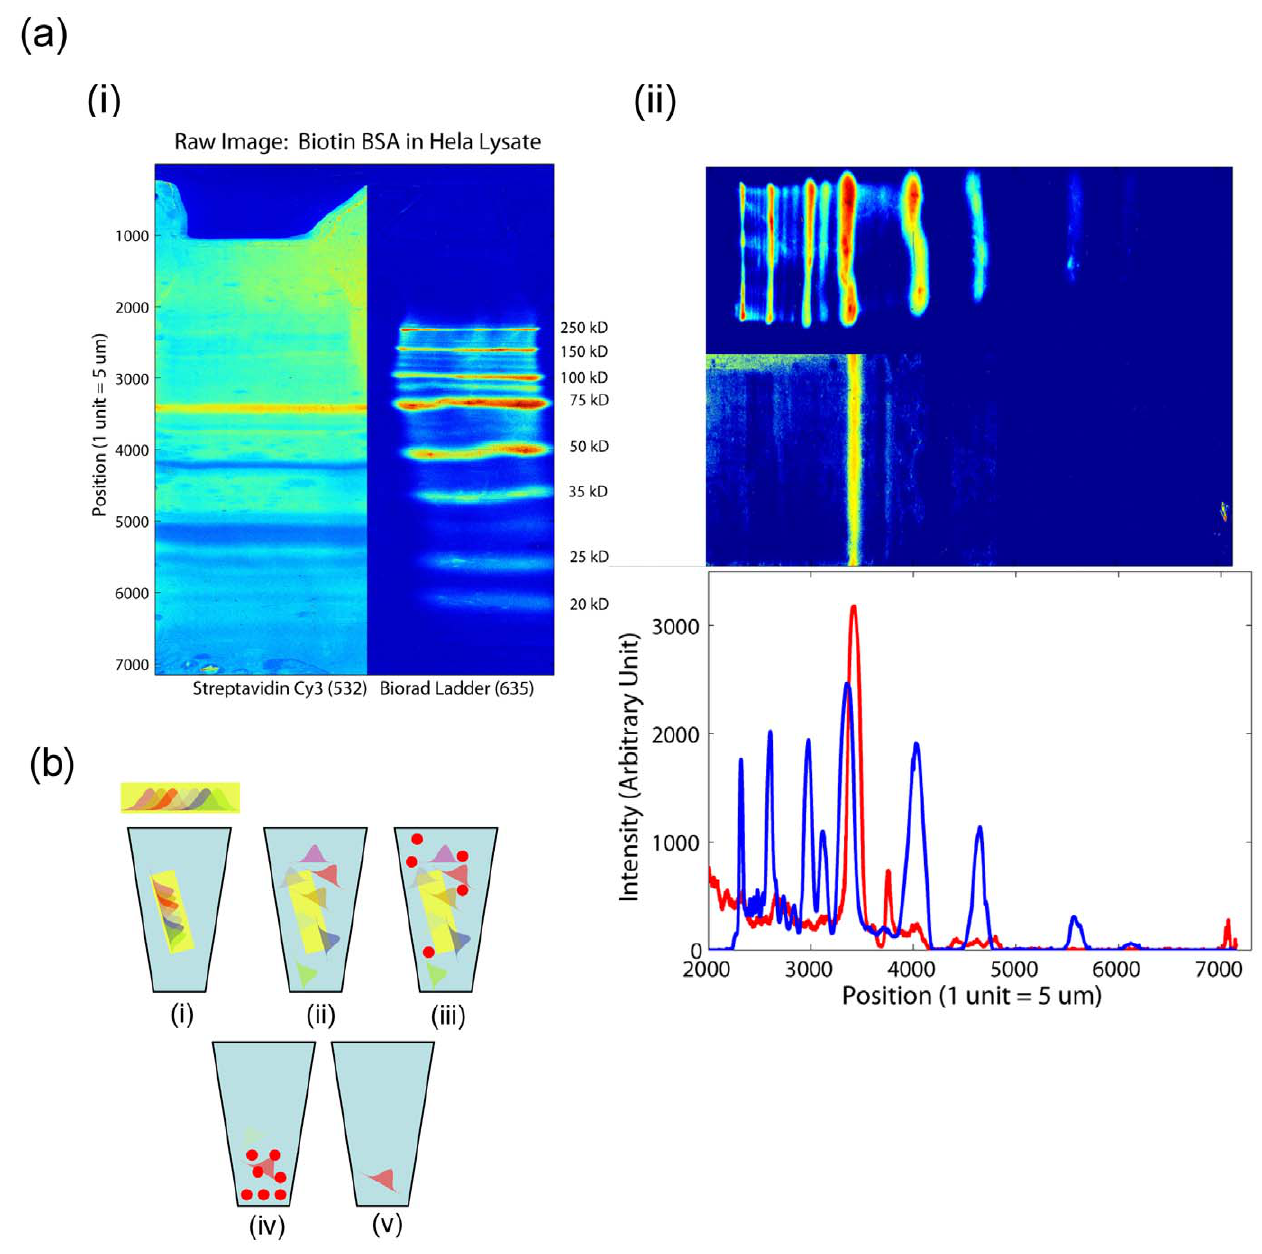
Figure 2. Identifying Protein-Protein Interactions. (a.i) HeLa cell lysate with Biotin BSA probed with streptavidin Cy3. The Cy3 channel is shown on the left, and the Cy5 channel showing the ladder in the neighboring lane, is on the right. The images shown are the unprocessed images. The lower molecular weight bands have a wider width. (a.ii) The images are filtered using a 2D Weiner filter in MATLAB, rotated 90 degrees, and thresholded to more clearly delineate the streptavidin band. This is useful for weaker signals which must be distinguished from the background, as well as to more accurately define the peaks of each band, enabling more accurate mapping to the gel. The filtered image is then averaged across the gel lane, further increasing signal to noise, and the signal as a function of position is plotted. The Cy3 trace (streptavidin) is plotted in red, and the ladder is plotted in blue. The position of the ladder peaks allows alignment of the gel and the transfer slide. (b) To further isolate the protein that is in the excised band, K of the band is eluted in PBS (i) over 48 hours (ii). Streptavidin coated magnetic beads are placed in solution (iii), allowed to bind, and then washed (iv). The beads are eluted in 8 M guanidine HCL (v), and the resulting solution is subjected to mass spectrometry. doi:10.1371/journal.pone.0046382.g002 The primary limitation of DiG-Stamping in comparison to limitations of all gel-based techniques. Care must also be taken in spotted arrays is the preferential transfer of high-abundance and correlating the protein position on the slide image to the gel. low molecular-weight proteins (LMWPs), and the lateral diffusion Gel transfer efficiency and protein detection limits were of LMWPs diminishing spatial resolution. This makes isolation of characterized using a fluorescently-tagged streptavidin as a individual proteins more difficult, but this is consistent with the secondary binding agent. This allowed for accurate comparison across both Western blots and DiG-Stamping, but the robust